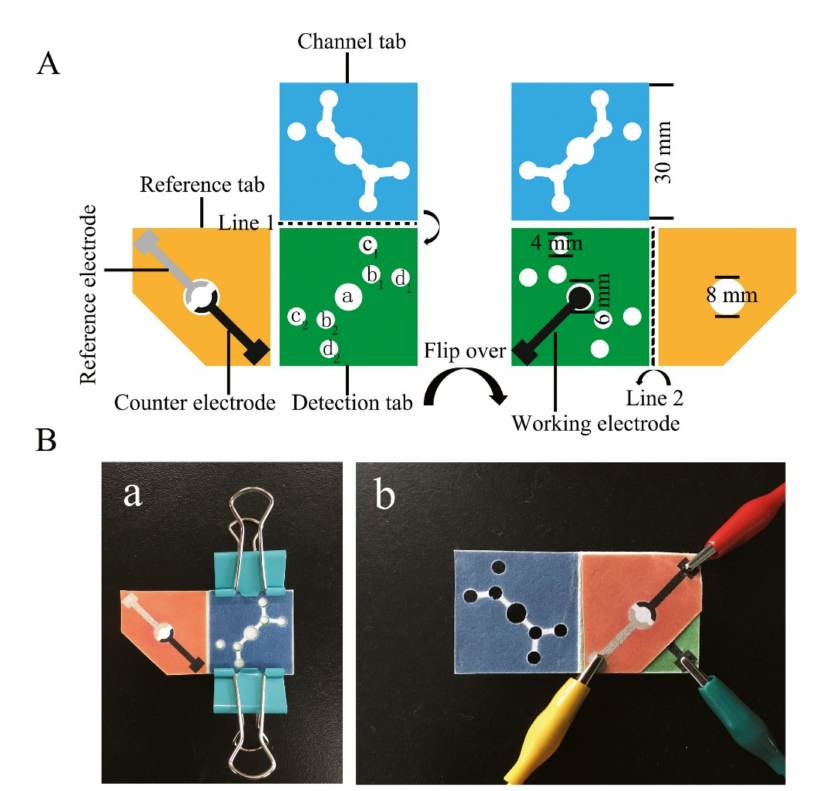
Figure 5. ( A ) Schematic representation and ( B ) fabrication of µ PADs for the detection of miRNA combining chromogenic reaction and electrochemistry. Reprinted from [66] with permission from El-